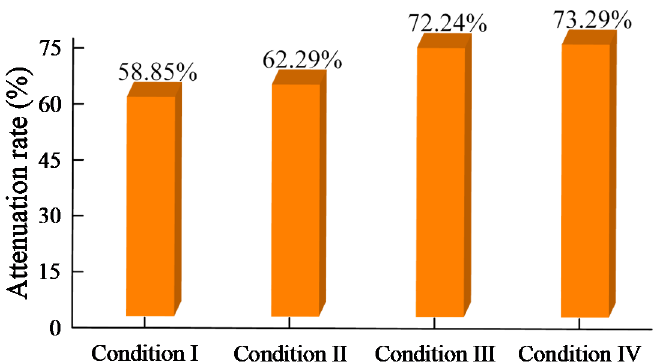
Figure 14. Blast velocity attenuation rate of feature points B 1 –B 6 .